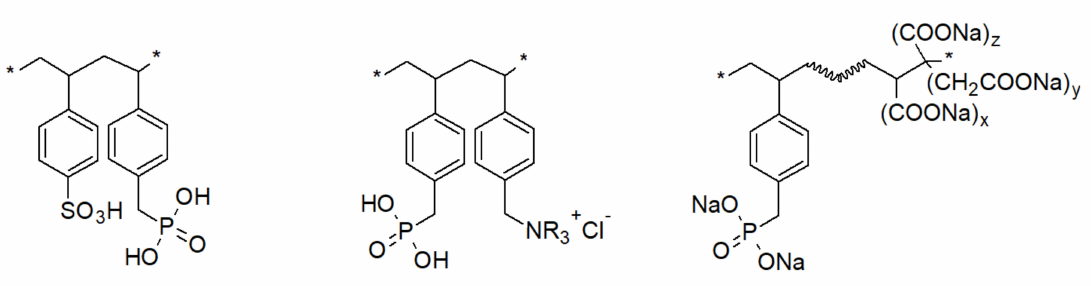
Figure 1. From the left: resin with phosphonic and sulfonic functional groups [51], phosphonic and amino groups [99], phosphonic and various carboxylic groups